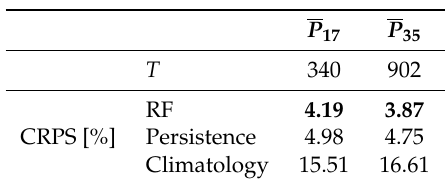
Table 3. Average continous ranked probability score (CRPS), in % of the nominal capacity ( P n ), for the five-minute ahead predictive densities of aggregated power of different sets of wind turbines. T indicates the sample size evaluated. Minimum values are shown in bold. Results are shown for the remote sensing-based forecasting (RF) model, persistence and climatology